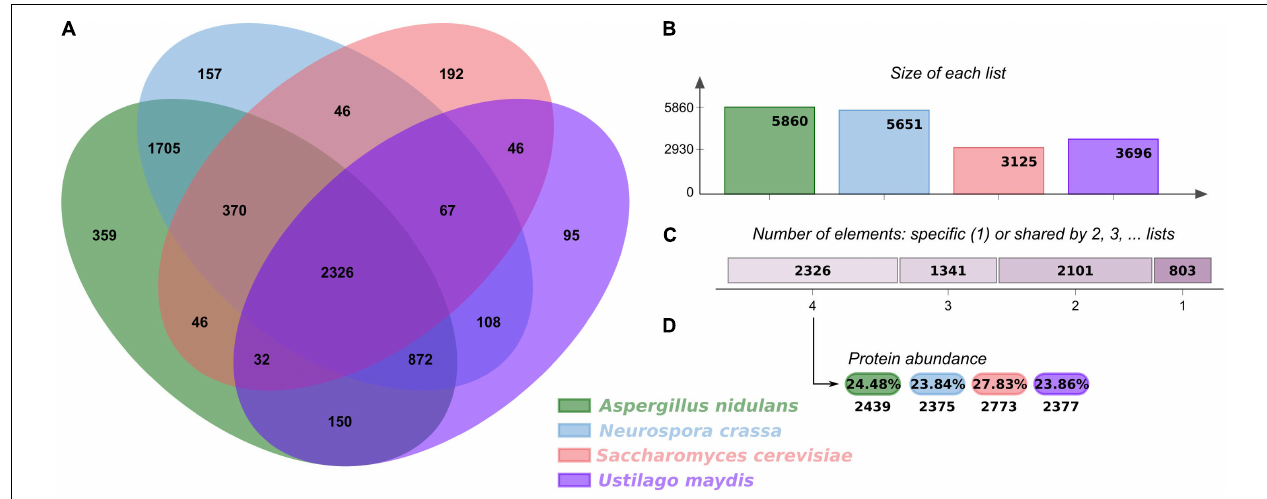
FIGURE 1 | Orthologous proteins shared between U. maydis, A. nidulans , N. crassa , and S. cerevisiae. (A) Venn diagram comparing orthologous clusters of whole proteomes. (B) The bar plot graph shows the number of orthologous clusters by organism. (C) The plot indicates the number of clusters that are organism specific or shared by 2, 3, or 4 organisms. (D) For the 2326 clusters shared by 4 organisms, the protein abundance levels (in percentages and absolute numbers) are shown for each